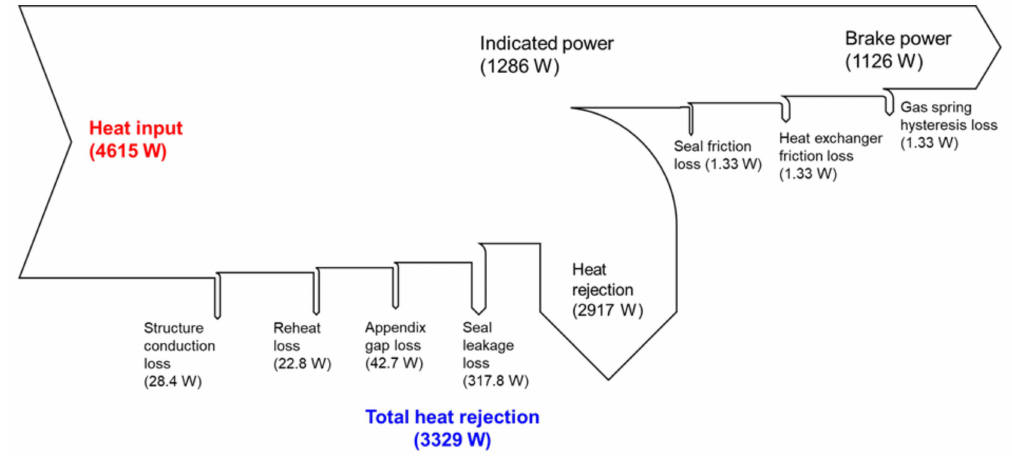
Figure 8. Energy flow of iQSF model for the RE-1000 engine.